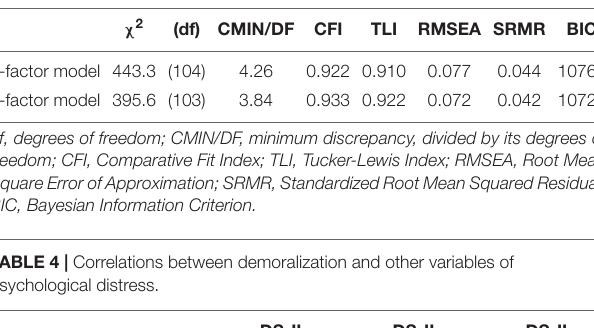
TABLE 3 | Summary of fit indices of the models.